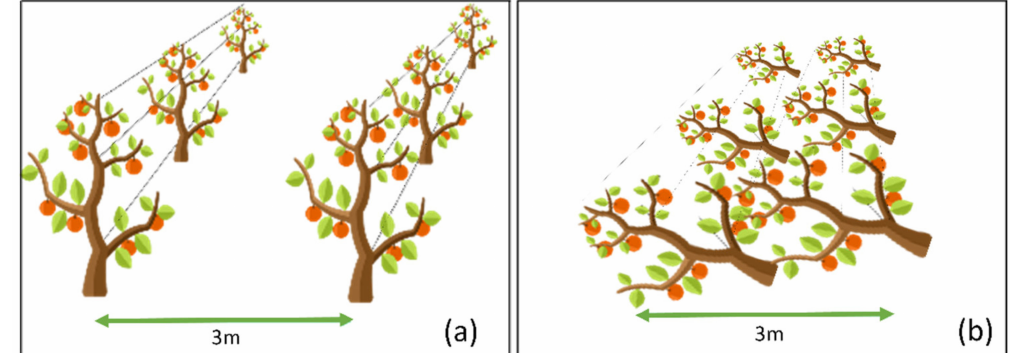
Figure 8. A sketch representing orchard condition before ( a ) and after ( b ) the storm. In ( a ) the pattern row/inter-row is well defined; ( b ) after the storm, apple tree uprooting occurred, altering the row/inter-row pattern, and crowns covering the ground increased volumetric